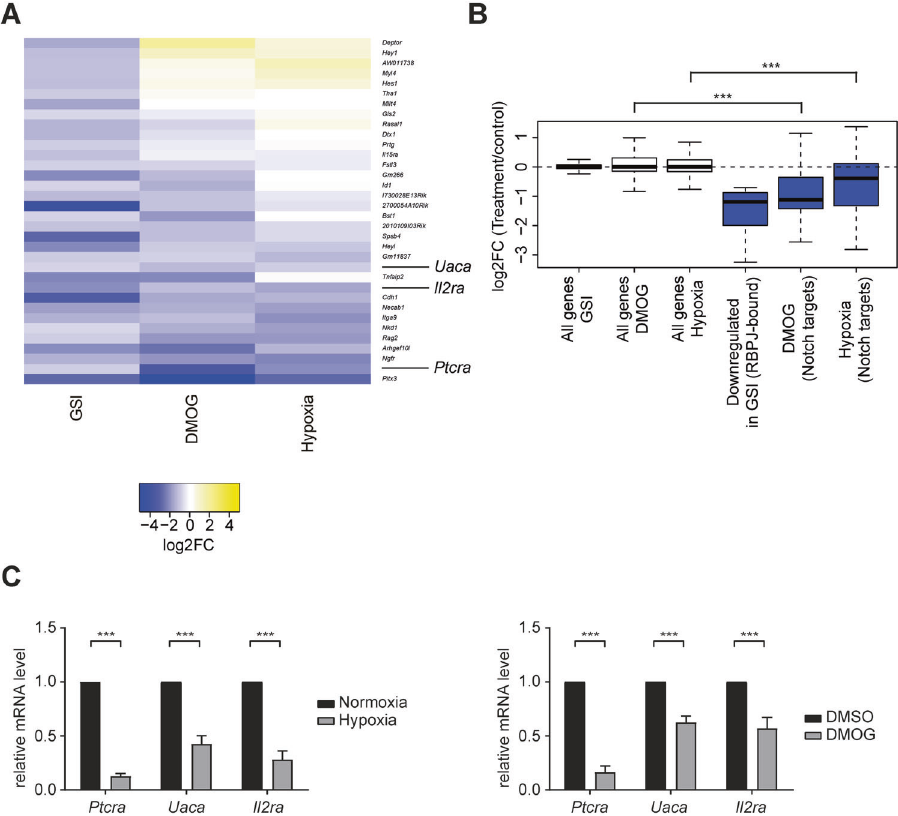
Fig. 1 Hypoxia downregulates the Notch-dependent gene expression program. Beko cells were treated with 10 μ g/mL GSI [32], 0.5 mM DMOG, or with DMSO as a control for 24 h. Alternatively, cells were kept for 12 h in hypoxia (1% O 2 ) or normoxia (5% O 2 ) as a control. RNA